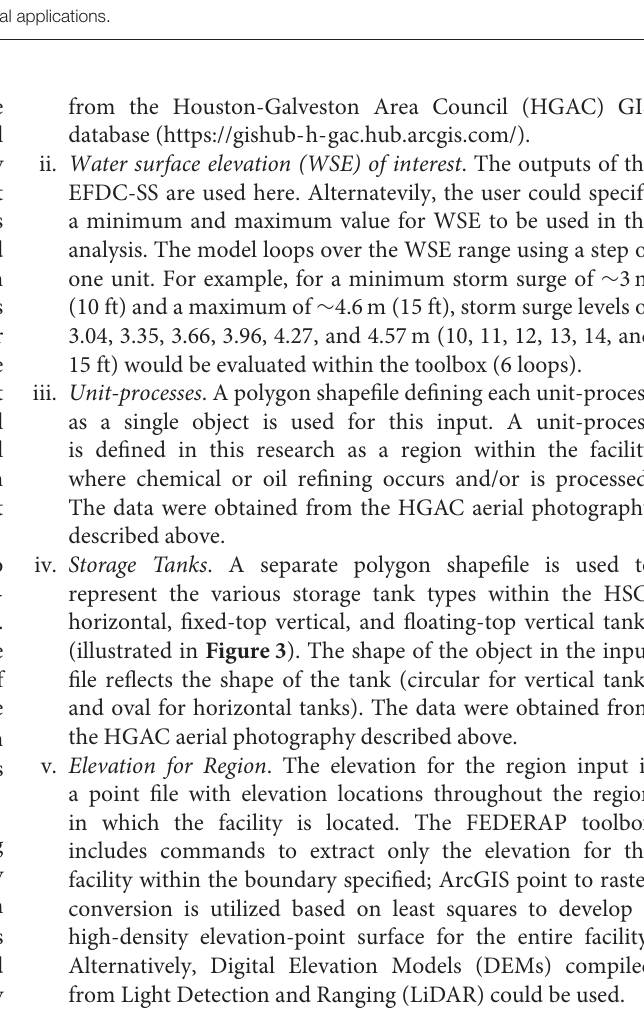
FIGURE 1 | EFDC-SS framework with the input information/models and potential